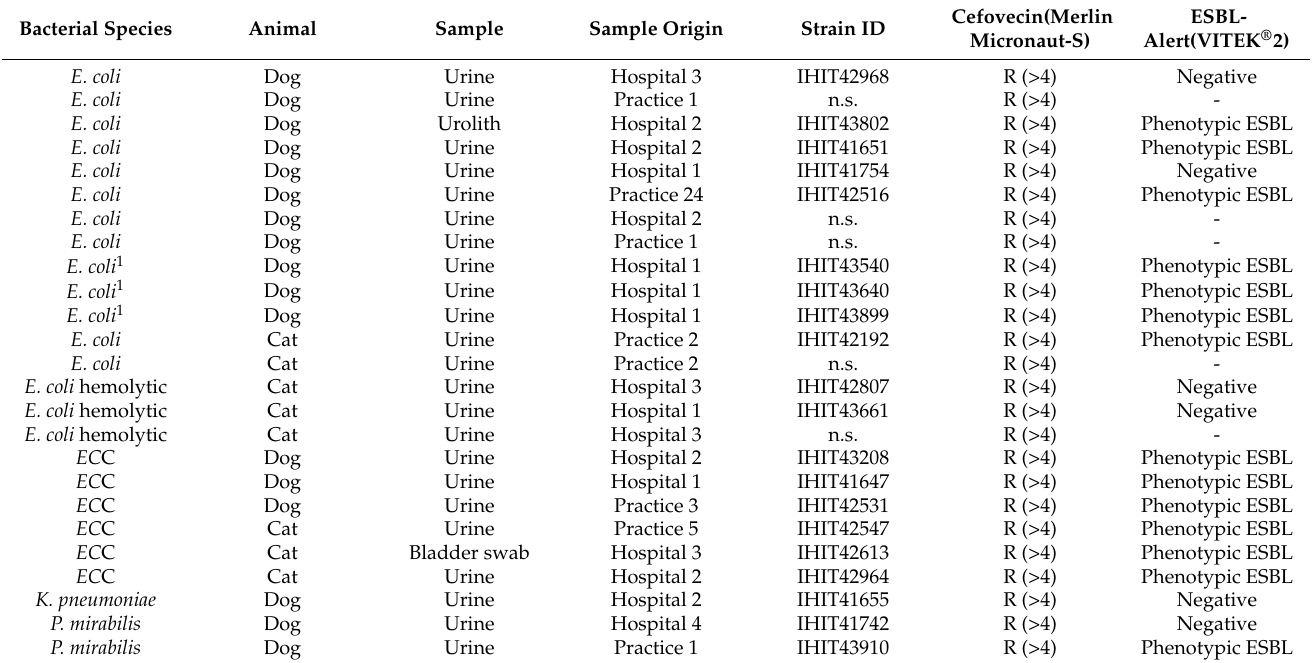
Table 9. Characteristics of third-generation cephalosporin-resistant Enterobacterales from dogs and